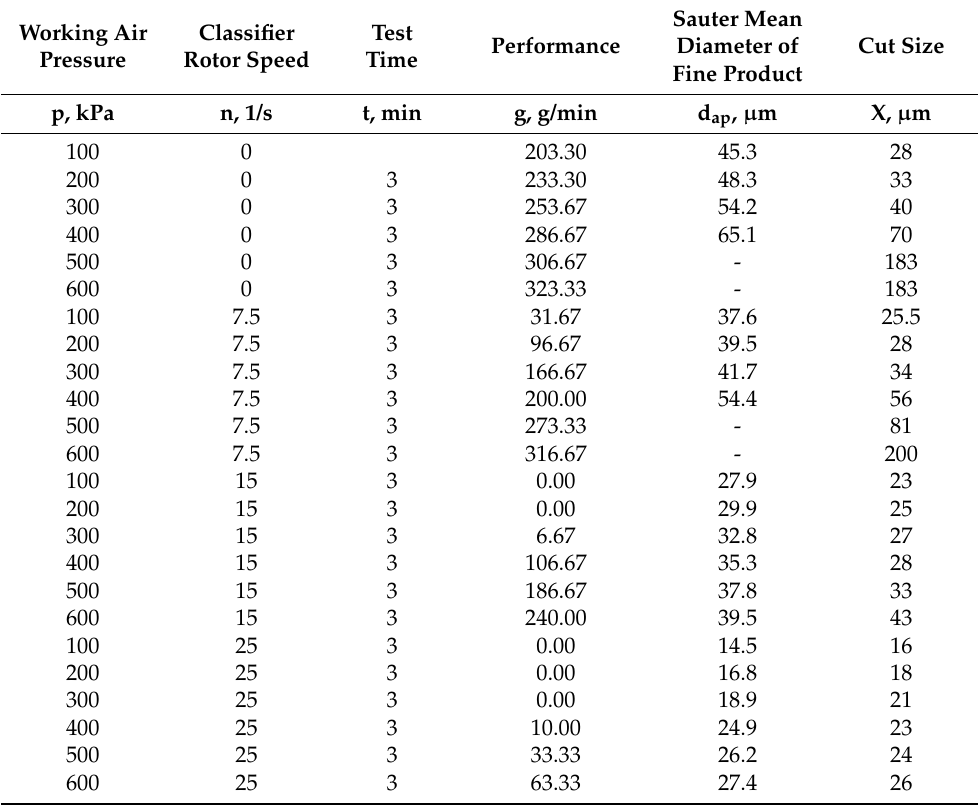
Table 2. Performance values, Sauter mean diameter of fine product and cut size for different rotational speeds of classifier rotor, and for different pressures of working air (second series).